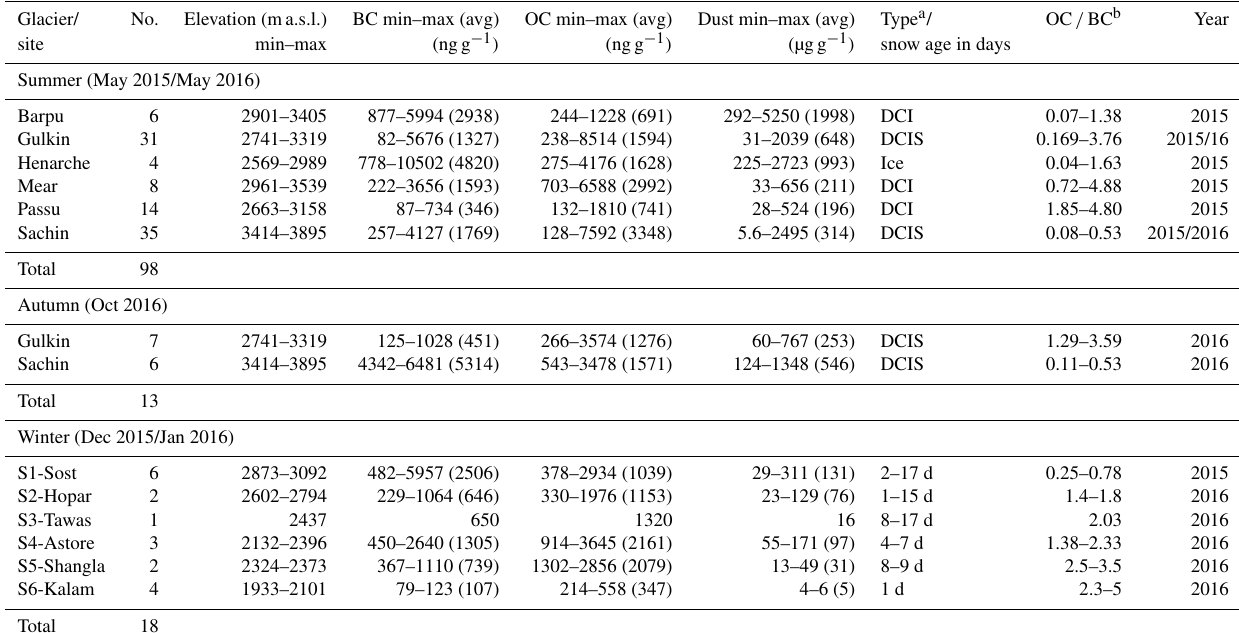
Table 1. Concentration of black carbon, organic carbon, and dust in summer, autumn, and winter samples in 2015 and 2016. Glacier/